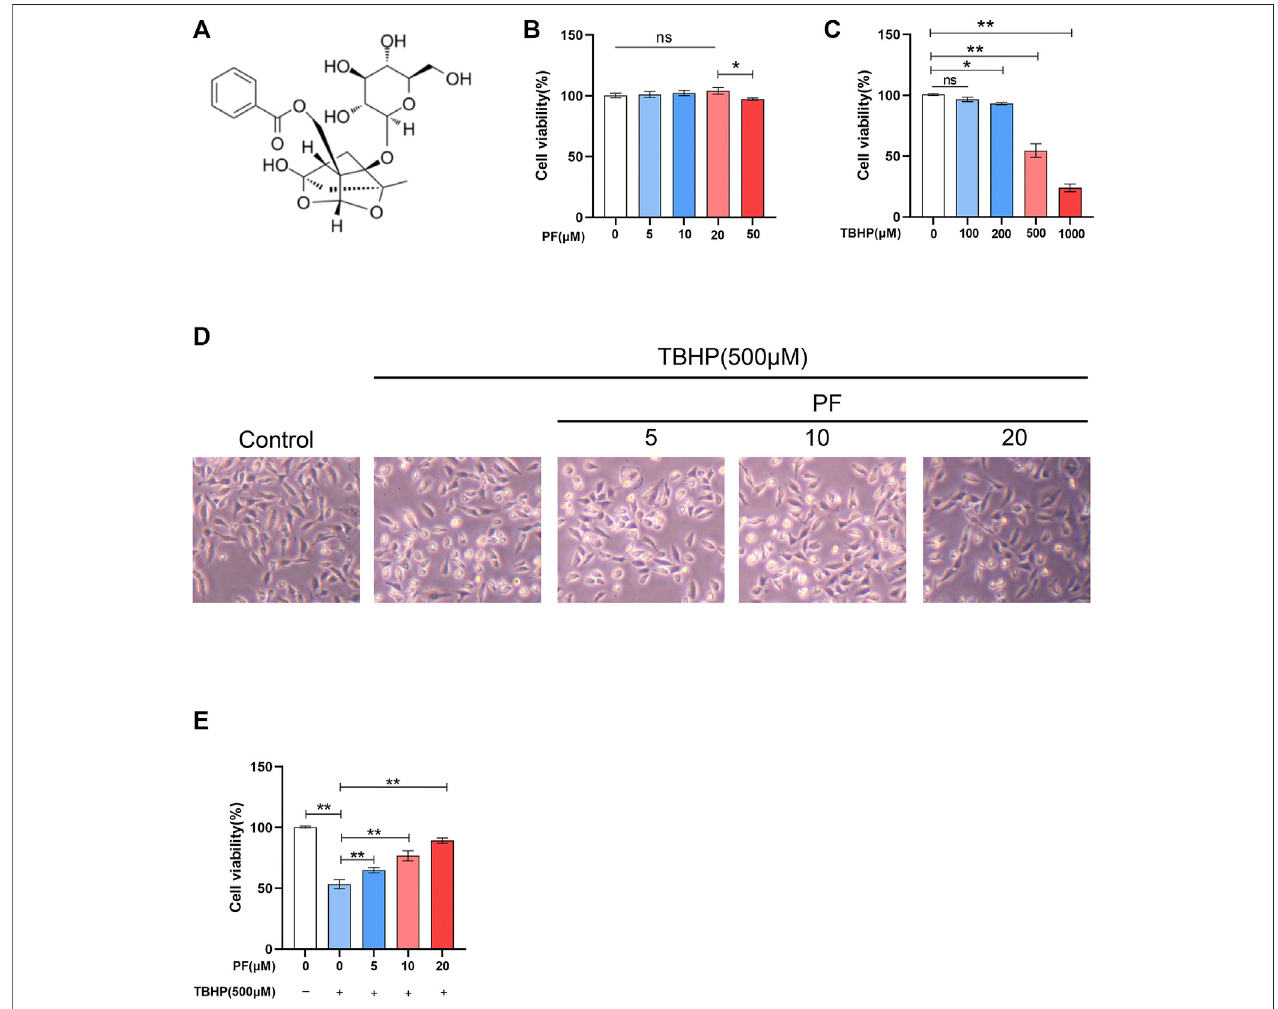
FIGURE 1 | Effect of paeoni fl orin (PF) on HUVECs. (A) PF chemical structure. (B) Evaluation of HUVEC viability using CCK-8 assay after exposure to differing concentrations of PF for 24 h. (C) Evaluation of HUVEC viability using CCK-8 assay after stimulation to different concentrations of TBHP for 24 h. (D) Representative images demonstrating cell morphology alterations in PF and TBHP co-treatment in HUVECs (scan bar, 100 μ m). (E) Evaluation of HUVEC viability using CCK-8 assay after PF and TBHP co-treatment in HUVECs. Data: mean ± SD, * p < 0.05 and ** p < 0.01. n (cid:2) 3.